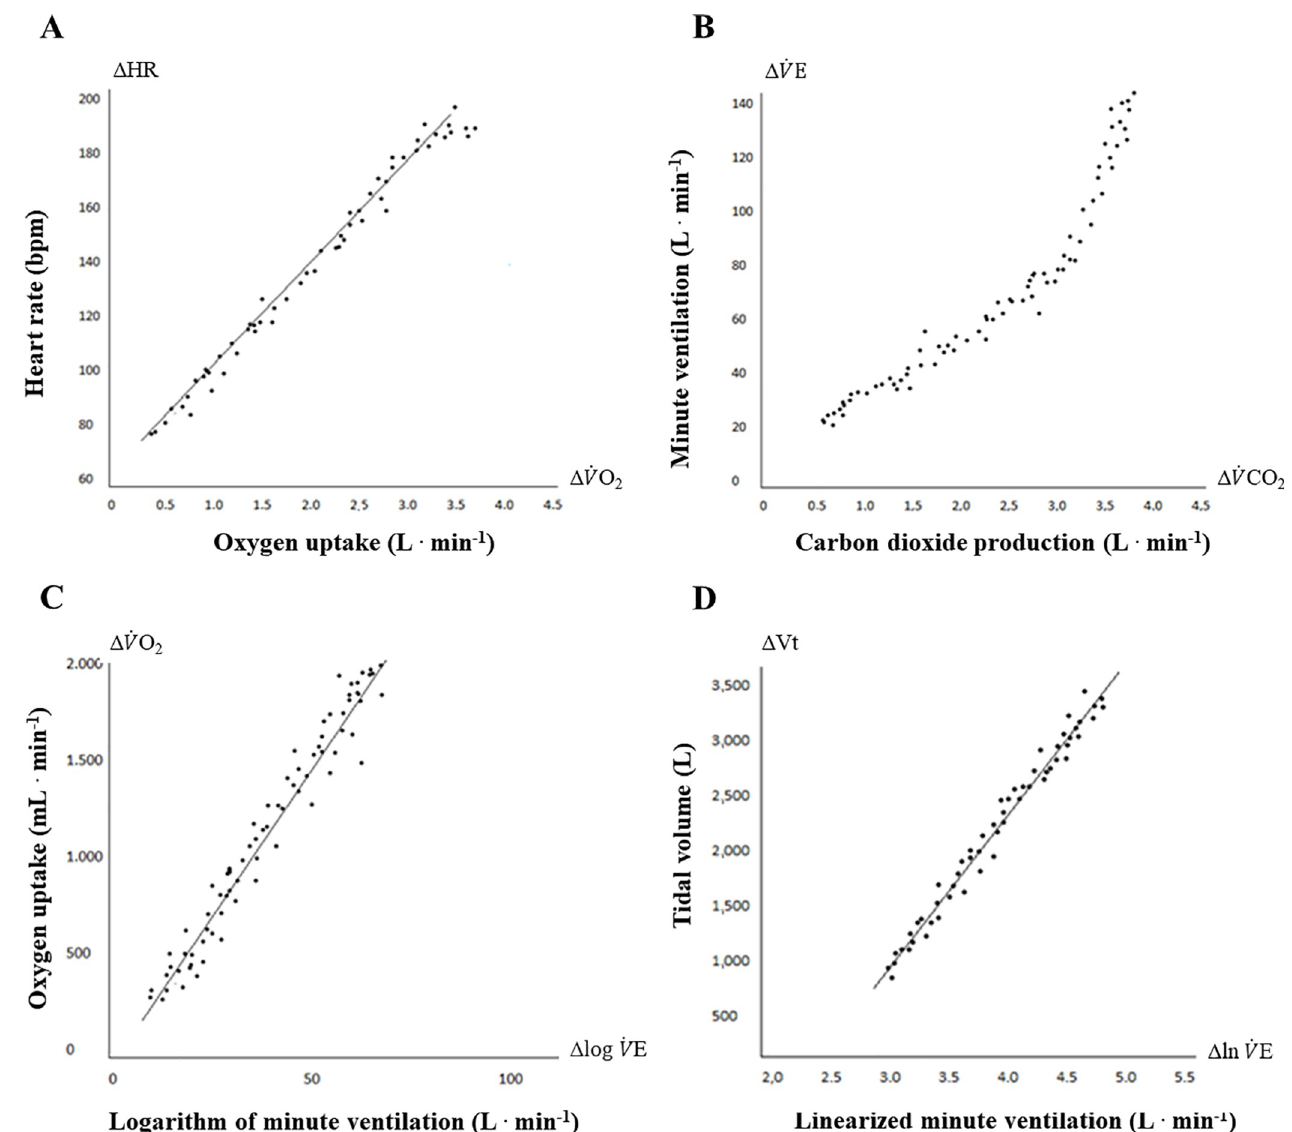
Fig 1. Procedure used to establish the dynamic physiological responses. (A) Cardiovascular efficiency ( D HR = D _ V _ O ( D _ V _ E = D _ V _ CO ). (C) Oxygen uptake efficiency slope ( D _ V _ O 2